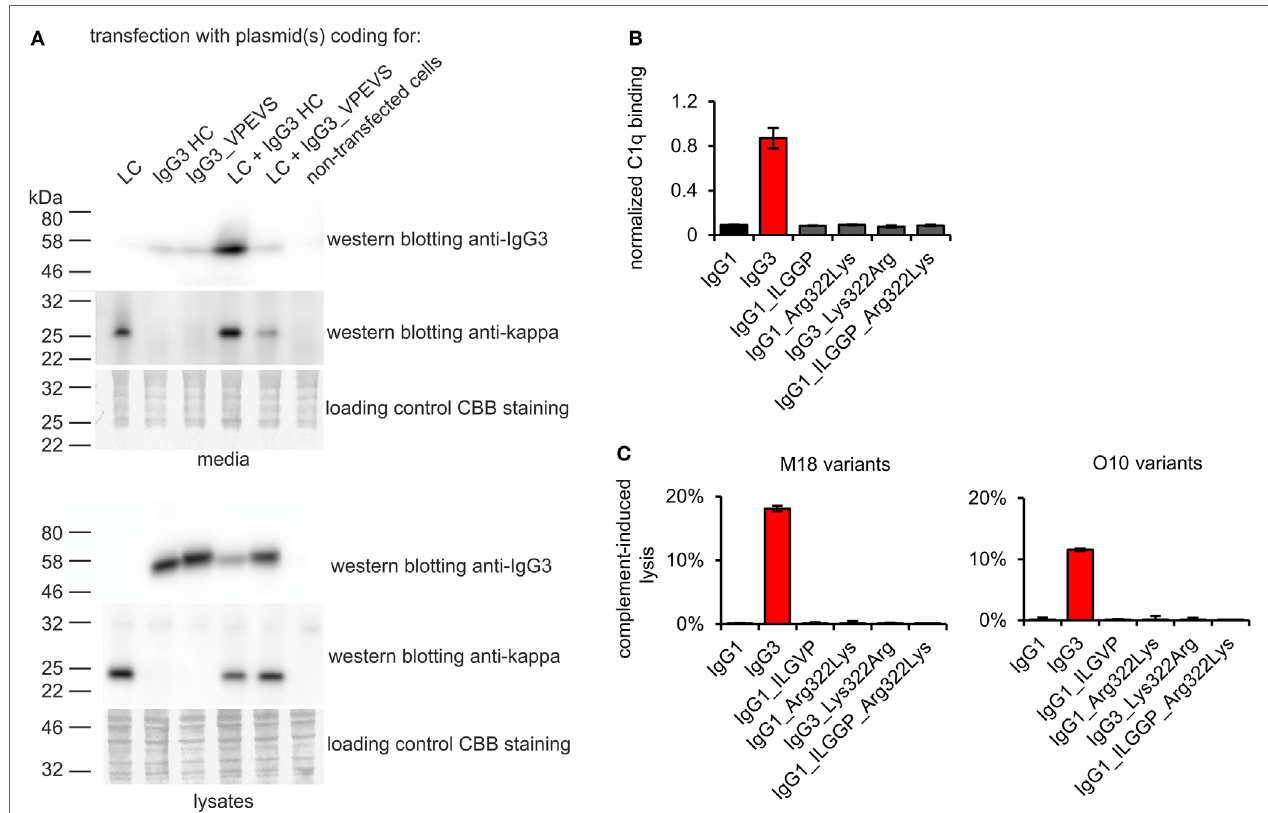
FigUre 5 | Functionality of known C1q-bining motifs in mouse IgG1 and mouse IgG3 frameworks. (a) IgG3_VPEVS did not associate with a light chain and was not secreted by the producing cells. (B) C1q binding by the muteins. Plates coated with BSA conjugated with the antigen, B-trisaccharide, were incubated with the muteins at 3 µg/ml (O10 variants). Then purified C1q was added. The muteins bind the antigen with different functional affinity. Thus, the C1q signal was normalized to the quantity of the bound antibody. Data used for calculation of the normalized binding are shown in Figure S7 in Supplementary Material. Error bars correspond to uncertainty calculated as presented in Section “Materials and Methods.” (c) Complement cascade activation by the muteins (3 µg/ml). Erythrocytes coated with the antibodies were incubated with complement serum. Complete lysis (100%) corresponds to water-induced lysis. In (a–c) representative results of two independent experiments are